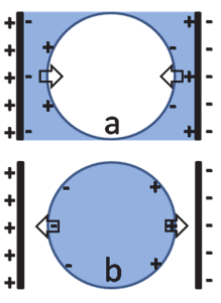
Fig. 2: Complementary polarization and force effects in air- water models. Induced charges are located in the medium with the higher polarizability. The interaction of these charges with the electrode charges, i.e. the external field, leads to a compression of the air bubble (a) and an elongation of the water droplet